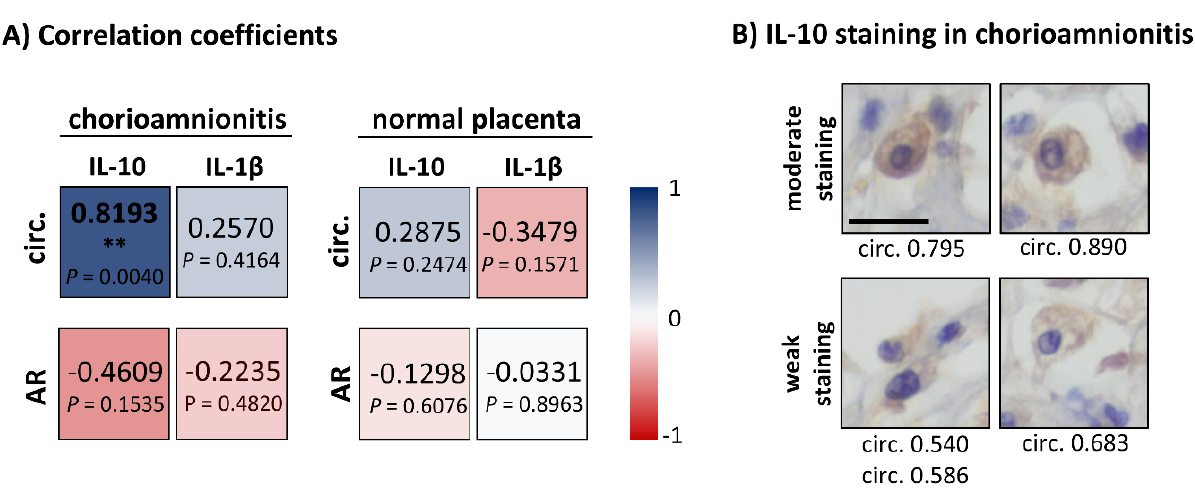
Fig. 2. Correlation of IL-10 and IL-1β with shape of Hofbauer cells. A ) Spearman correlation coefficients for chorioamnionitis and normal placenta. Statistically significant results are marked by *. B) IL-10 staining of Hofbauer cells. Microphotographs show IL-10 staining intensity. The circularity of displayed cells is indicated directly below the microphotographs. Circularity describes the roundness of cells, where 1.0 indicates perfect circle, as the value approaches 0.0, it indicates an increasingly elongated shape. Note higher staining intensity in rounder HBCs. Magnification 400x, black line represents 20